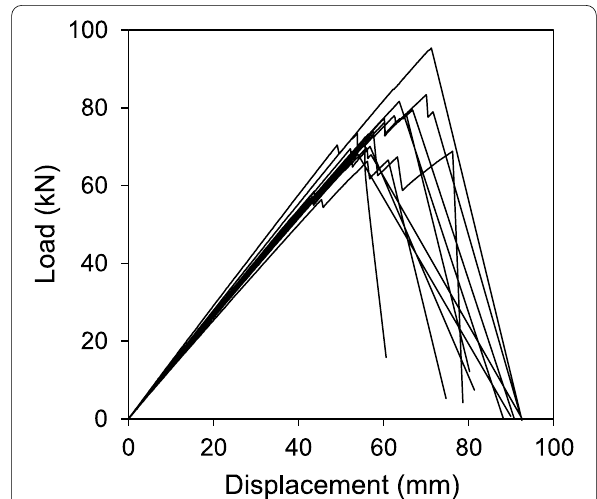
Fig. 4 Load–displacement curves of the short-term loading tests